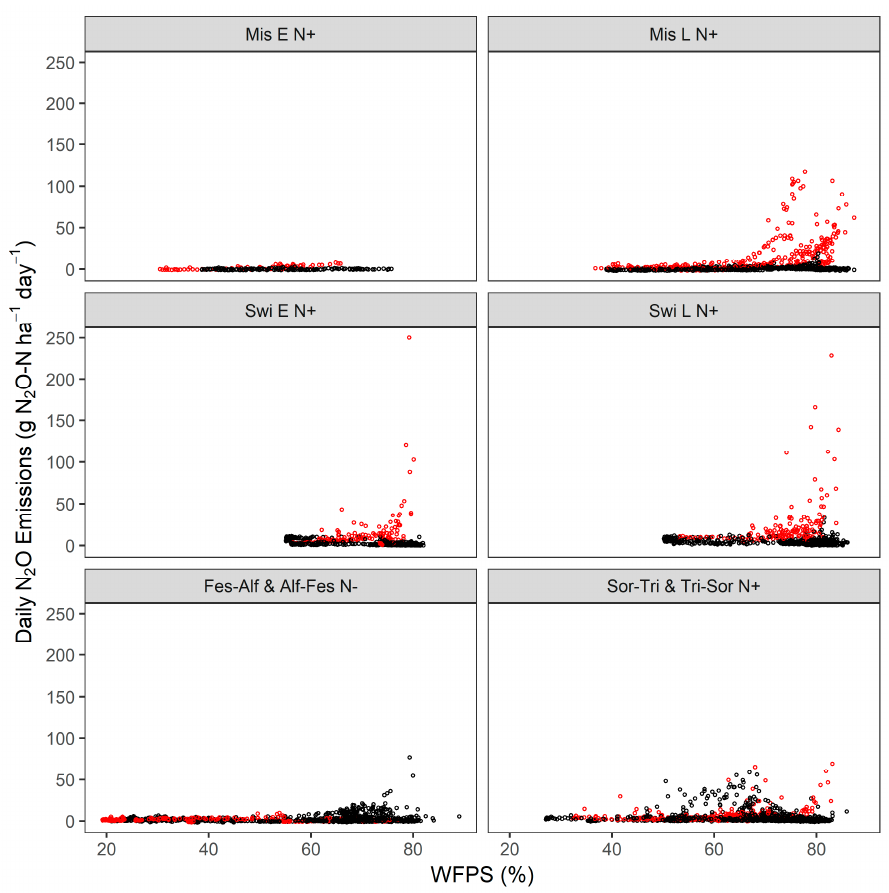
Figure 7. Relationship between daily N 2 O emissions and WFPS (0–30 cm) for all treatments except Mis L N − . Points in red are fluxes measured during the 70 days following N fertilization. See Table 1 for treatment abbreviations.